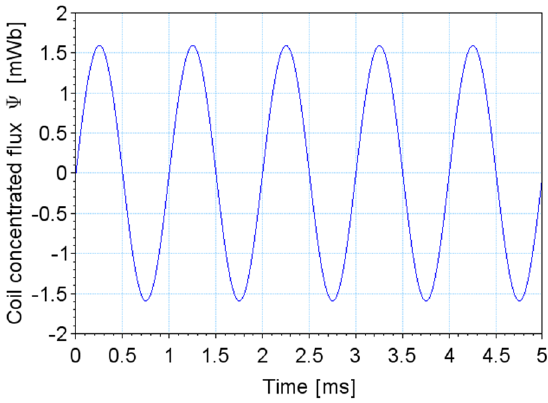
Figure 7. Coil concentrated flux Ψ waveform.